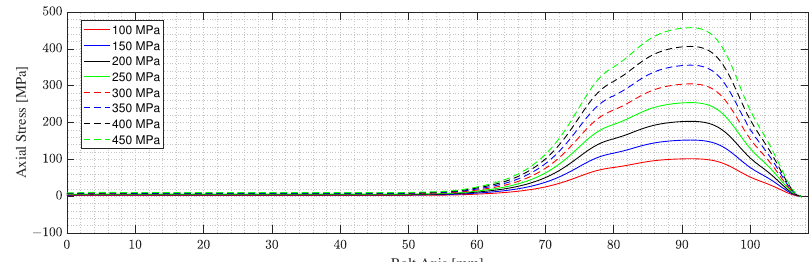
Figure 5. Stresses ( T 11 ) along the bolt axis for different pre-tensioning load.